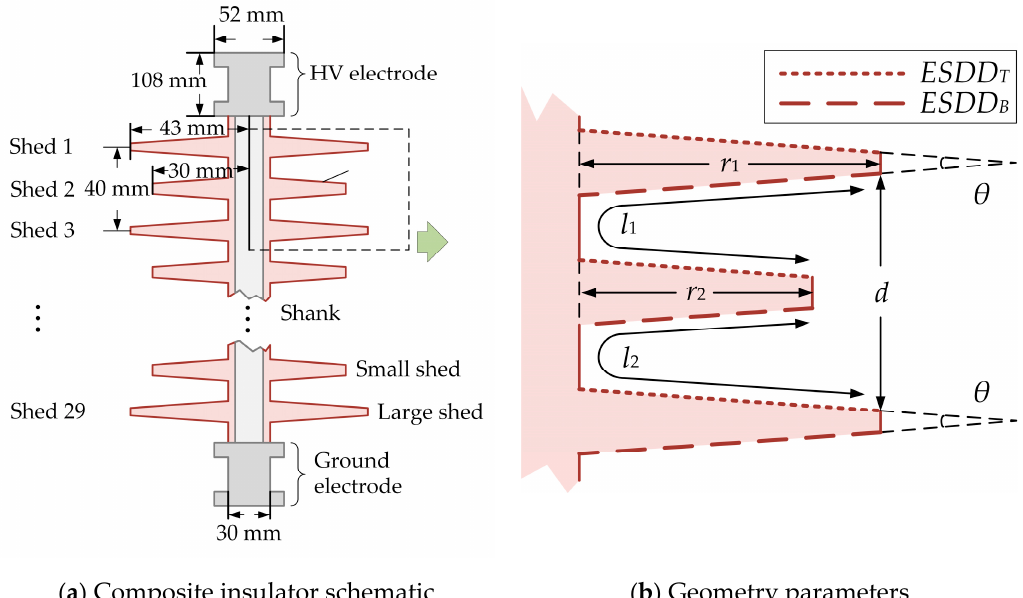
Figure 1. Composite insulator model schematic.